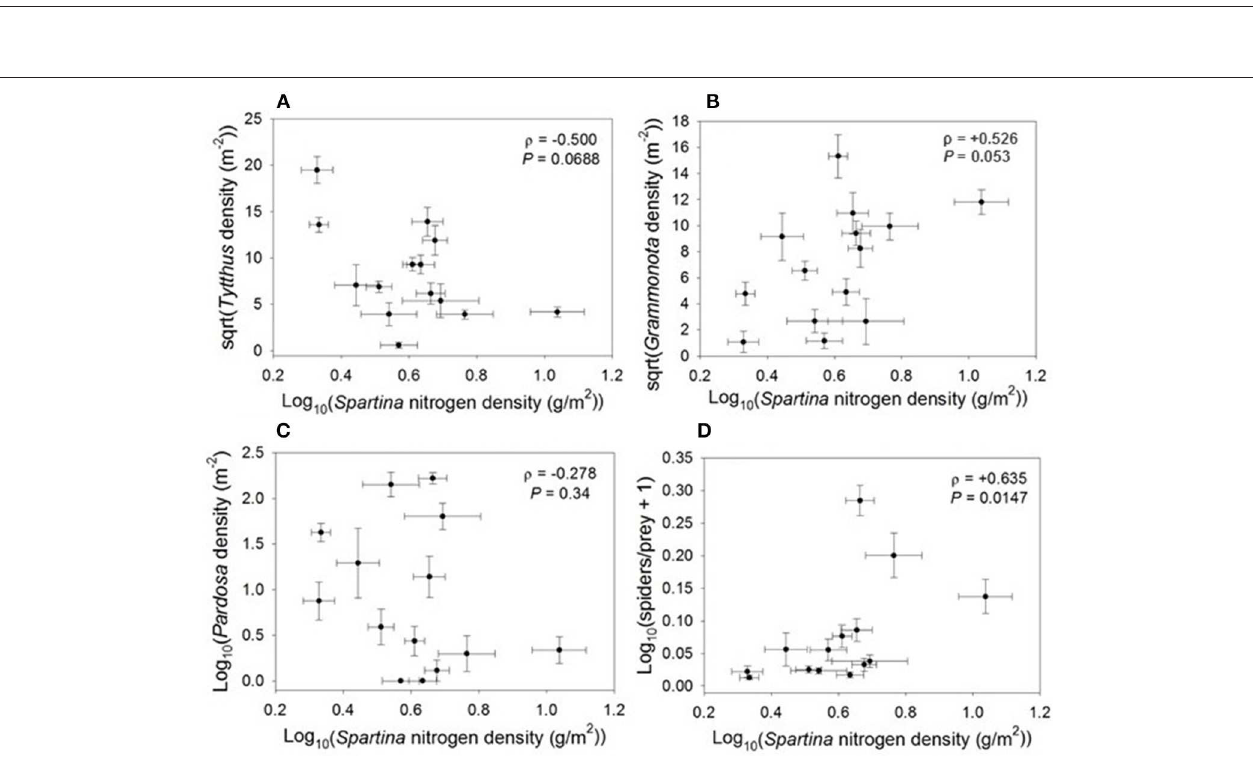
FIGURE 4 | Correlations between Spartina nitrogen density and (A) Tytthus density, (B) Grammonota density, (C) Pardosa density, and (D) spiders-to-prey ratio.